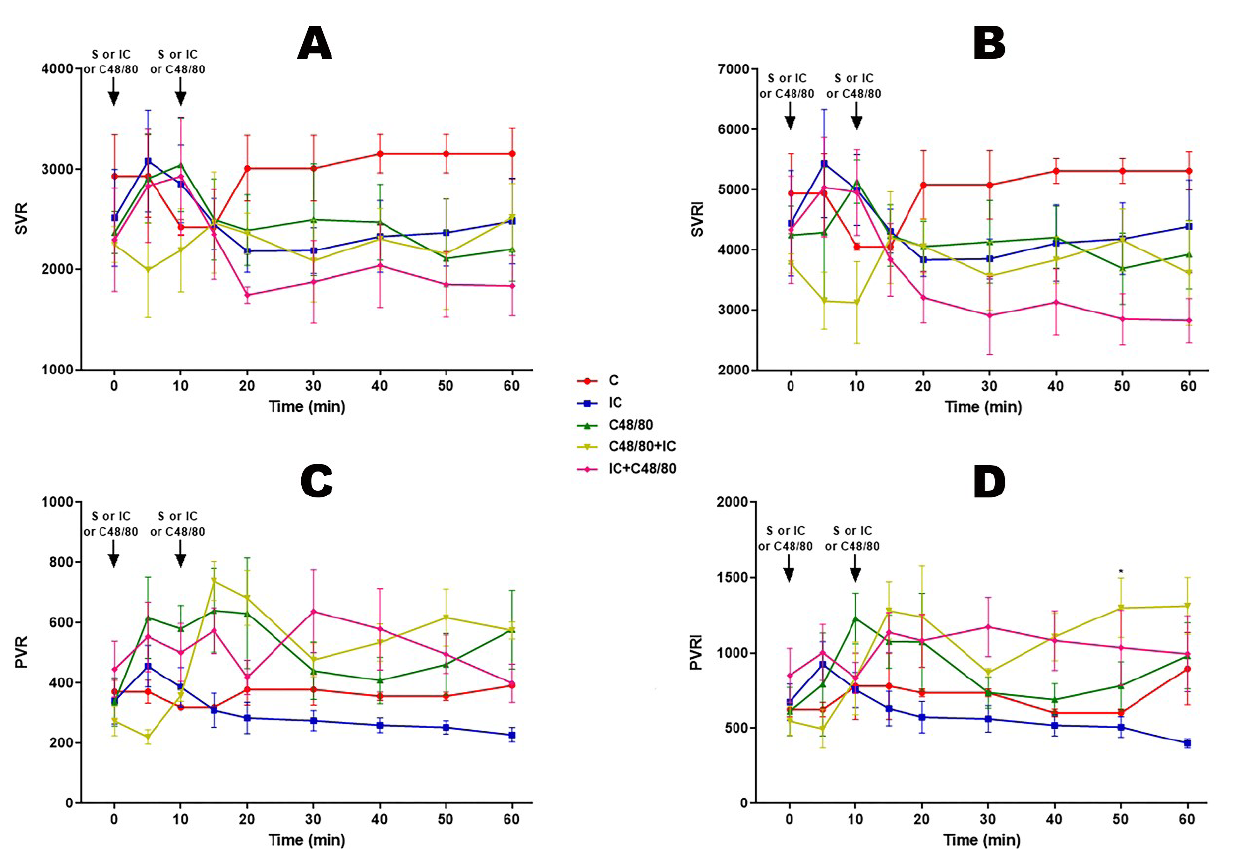
Fig. 3 - Vascular resistances. Effect of anaphylactic shock caused by compound 48/80 (C48/80) and treated with indigo carmine (IC) in pigs. A) Systemic vascular resistance (SVR); B) systemic vascular resistance index (SVRI); C) pulmonary vascular resistance (PVR); D) pulmonary vascular resistance index (PVRI). At minute 0, the control (C) group received saline (S), the C48/80 and C48/80+IC groups received C48/80, the IC and IC + C48/80 groups received IC. At minute 10, the C, IC, and C48/80 groups received S, the C48/80 + IC group received IC, and the IC + C48/80 group received C48/80. Data represent means ± standard error of mean and analyzed by two-way analysis of variance (ANOVA), Dunnett post-test (n=5). *P<0,05; (*C vs.